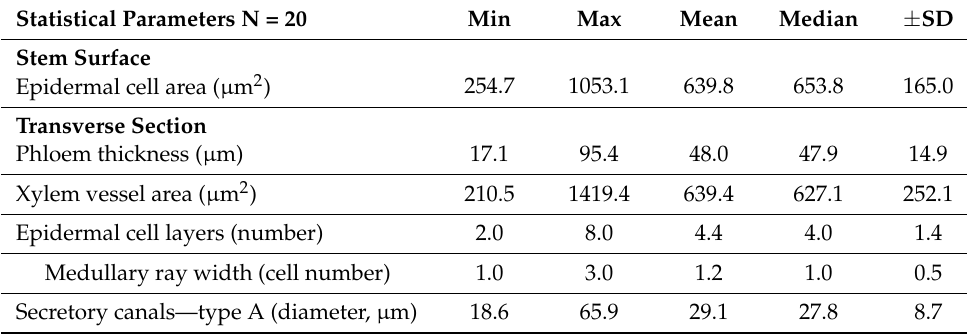
Table 2. Light microscopic characteristics of H. foliosum